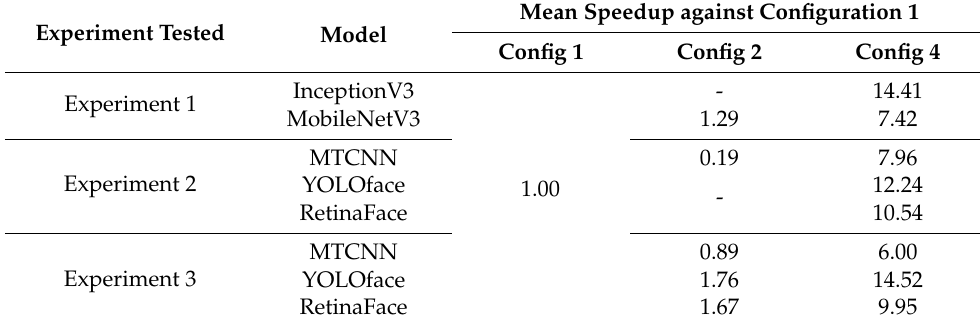
Table 10. Mean speedup against Configuration 1 in all